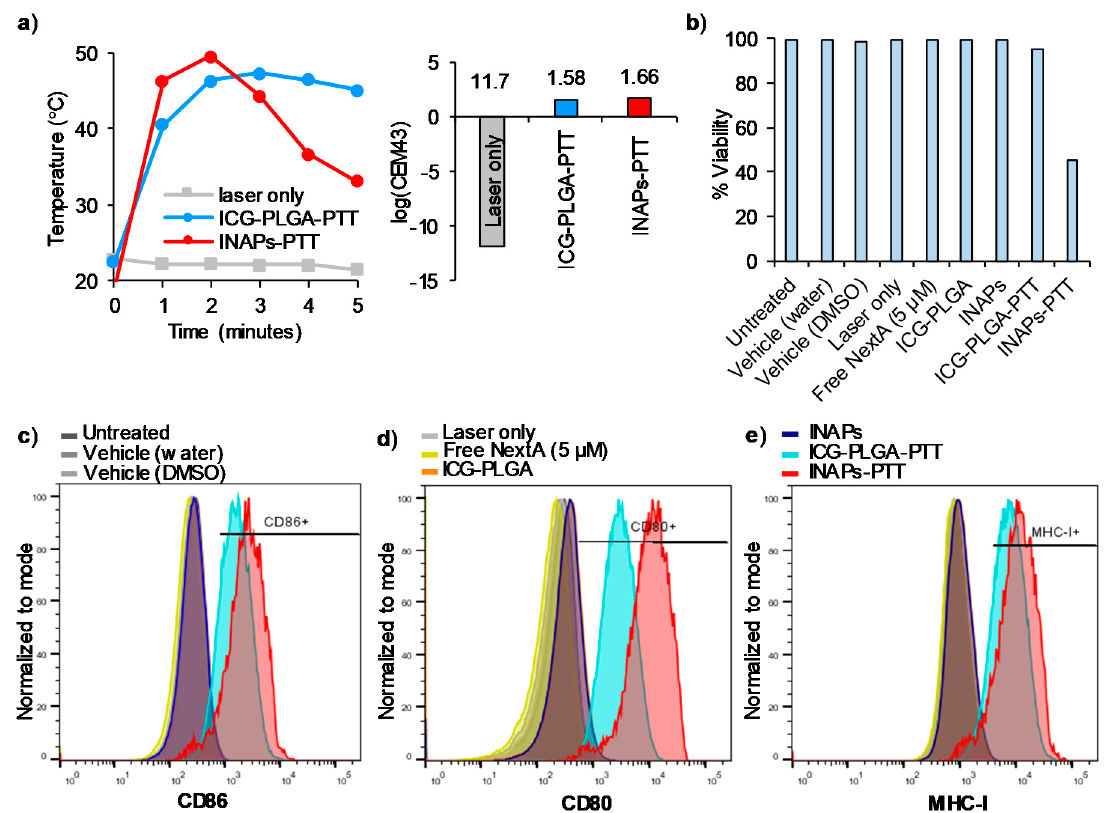
Figure 5. Increased cell surface expression of co-stimulatory molecules and MHC Class I on melanoma cells in vitro after INAPs-PTT. ( a ) Time–temperature heating curves at 1-min intervals and thermal doses expressed in terms of log (CEM43) of SM1 melanoma cells treated with INAPs-PTT and ICG-PLGA-PTT using a 0.4 to 0.6 W NIR laser for 5 min showed heating to approximately 50 ◦ C with a log (CEM43) value of ~1.6. ( b ) Viability of SM1 melanoma cells treated with INAPs-PTT, ICG-PLGA-PTT, and other control treatment groups showed 40% or higher viability after treatment, as measured by flow cytometry. Cell surface expression levels of co-stimulatory molecules ( c ) CD86, ( d ) CD80, and ( e ) MHC-I increased after INAPs-PTT and ICG-PLGA-PTT but not with other control treatment groups, as measured by flow cytometry (panels c–e x-axis units: logarithmic fluorophore expression levels, y-axis units: acquired events normalized to mode).